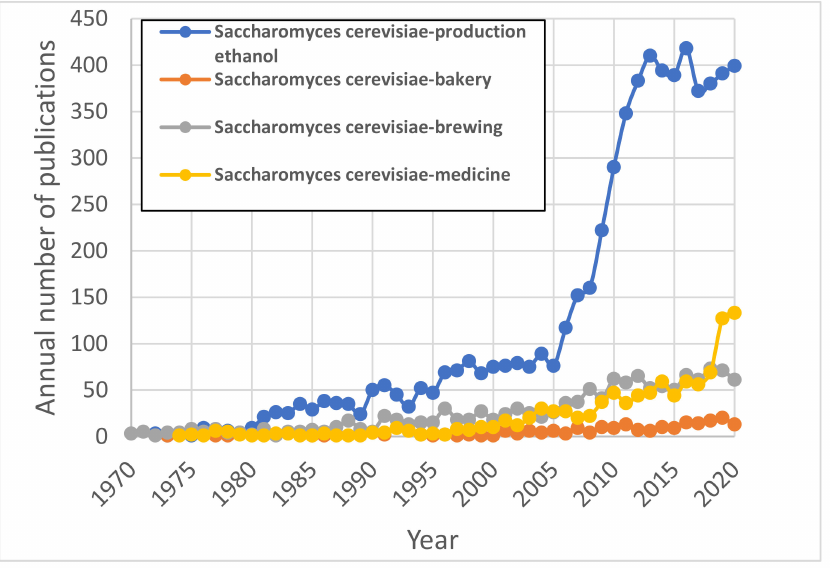
Figure 1. Annual number of publications of Sc applications in different areas (the legend indicates the keywords that were used when performing the SCOPUS engine